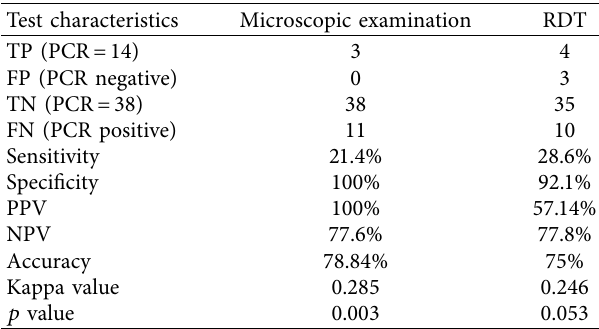
Table 2: Performance characteristics of microscopy and RDT when compared with real-time